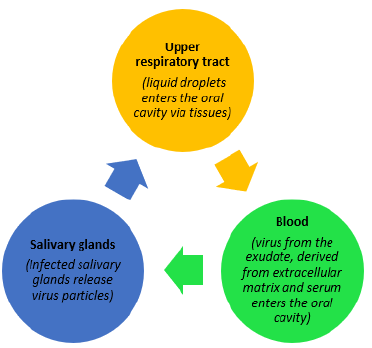
Figure 1. Possible trajectories for the presence of SARS-CoV-2 in saliva. Since mid-December 2019, global morbidity associated with COVID-19 has surpassed 119 million, contributing to more than 2.6 million global deaths [6]. In the United States alone 29 million people have been affected, resulting in nearly 528,456 deaths [6]. As in